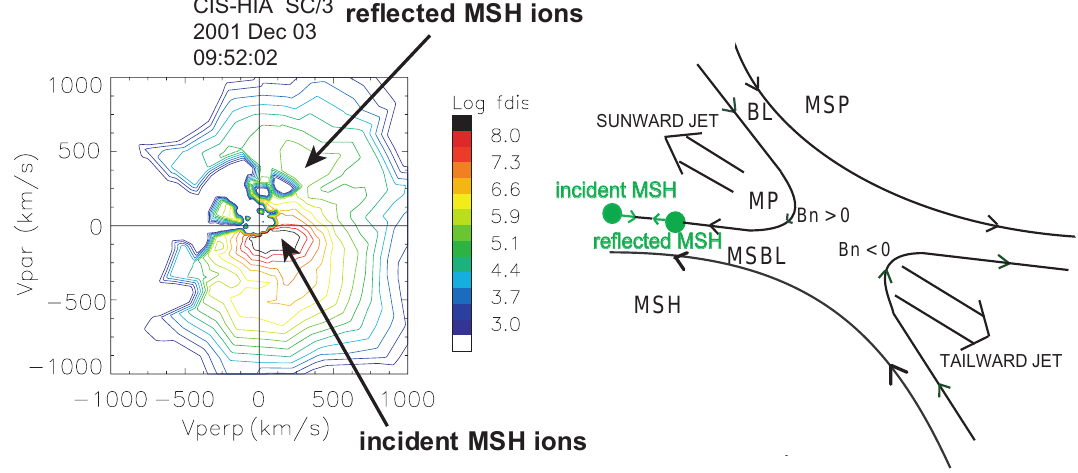
Fig. 7. SC/3 ion distribution function on the (V ⊥ ,V k ) plane at 09:52:22 UT when the spacecraft is in the MSBL. Incident and reflected populations are shown, as well as a sketch of the reconnection